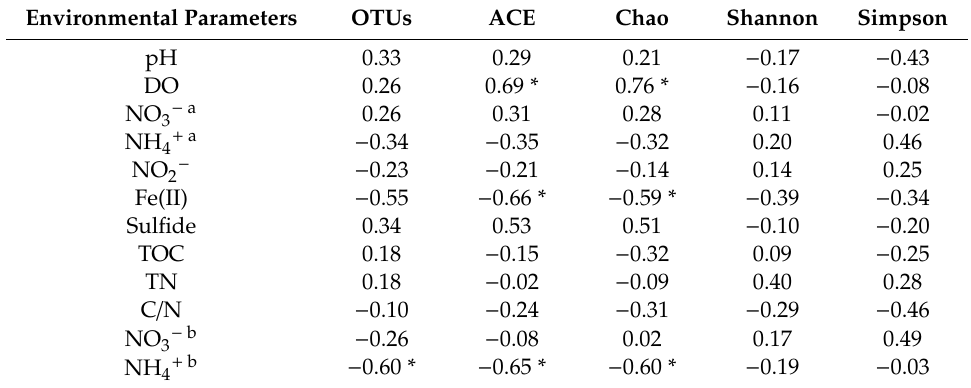
indicate a significant correlation.